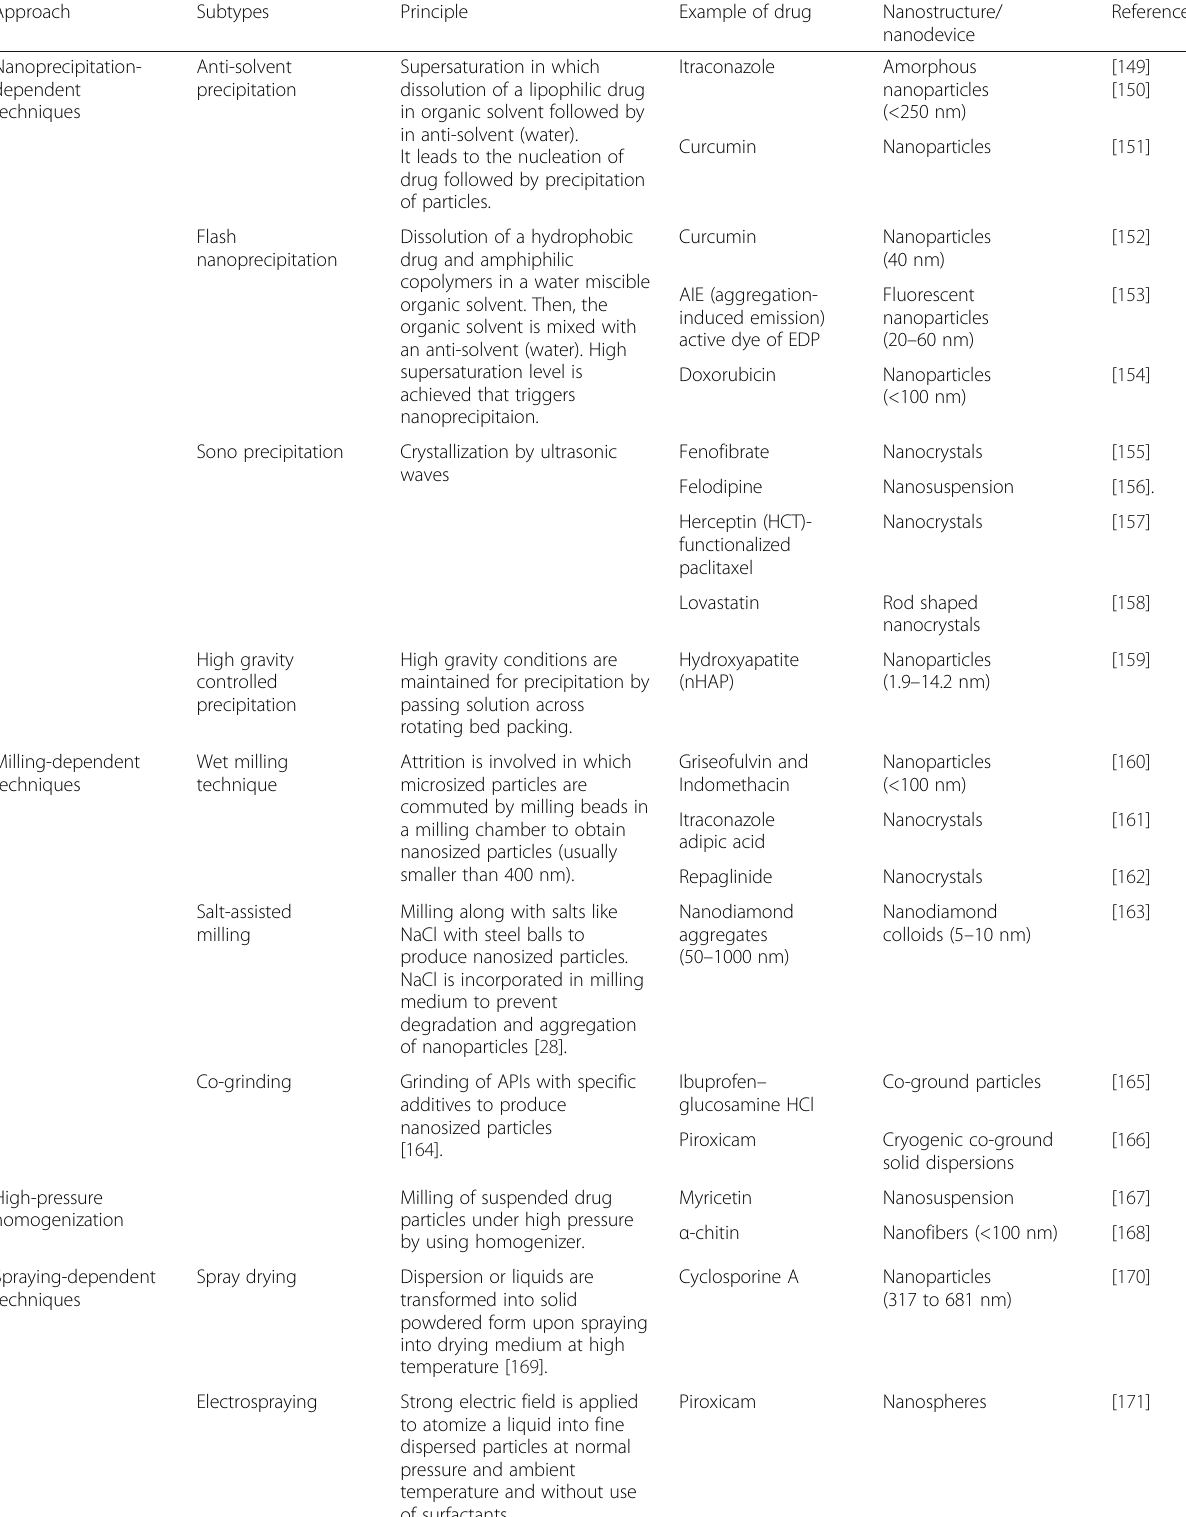
Table 2 Different approaches for manufacturing of various nanomaterials with their respective types